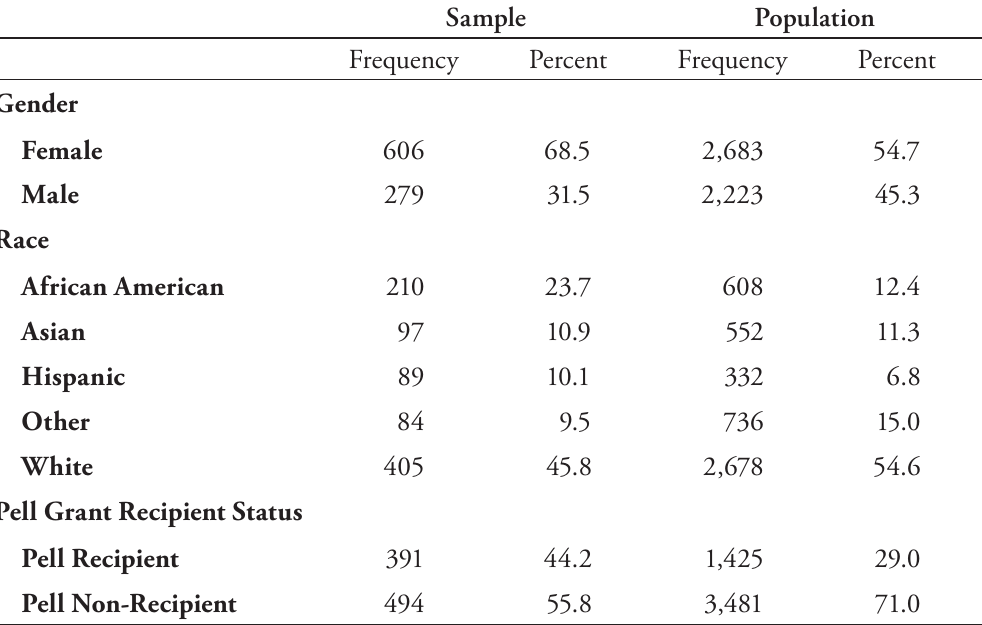
Table 1. Descriptive Statistics on the Sample and Population